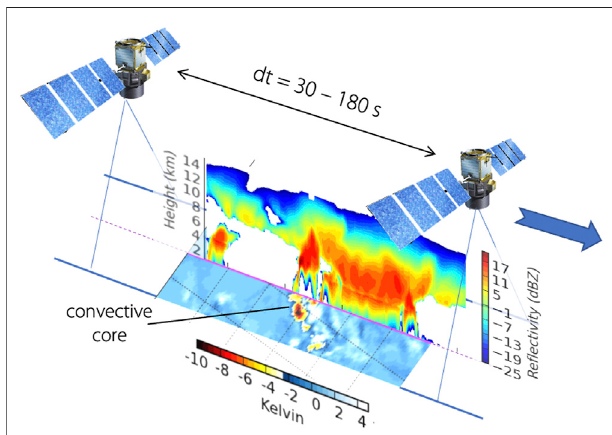
FIGURE 1 | schematic of a convoy of satellites carrying passive microwave instruments providing the horizontal map. The map reveals the intensity of in-cloud upward motion associated to condensed water from time differences of the brightness temperature (in K, over dt = 30s) measured at 183 ± 11 GHz. The vertical cross-section is the vertically-resolved concentration of hydrometeors (re fl ectivity) as provided by a radar (in the present case, the CloudSat radar at 94